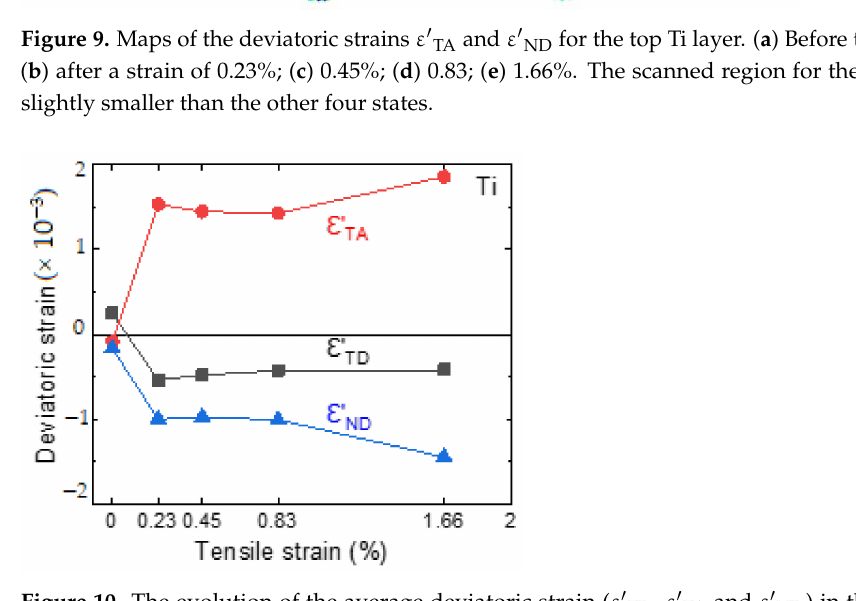
Figure 10. The evolution of the average deviatoric strain ( ε (cid:48) TD , ε (cid:48) TA and ε (cid:48) ND ) in the top Ti layer during tensile loading. The magnitude of the standard deviation is on the order of 10 − 3 . The 0.2% offset yield point strain for Ti is about